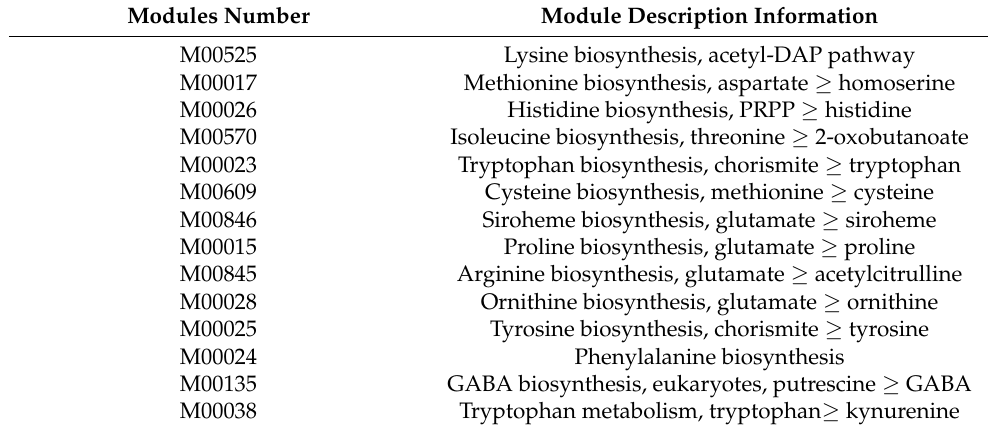
Table 2. Annotation of Modules related to amino acid